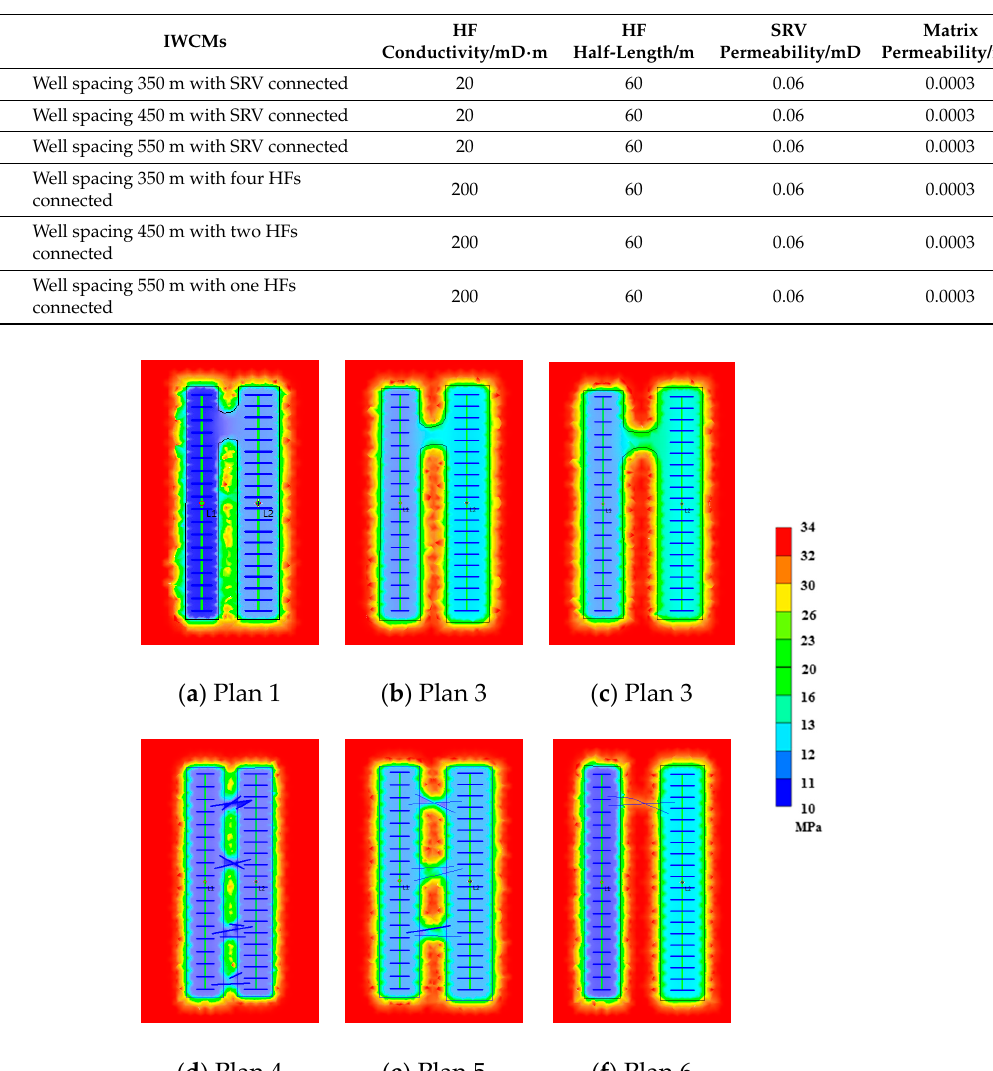
Table 2. IWMDs and basic physical properties of six plans.